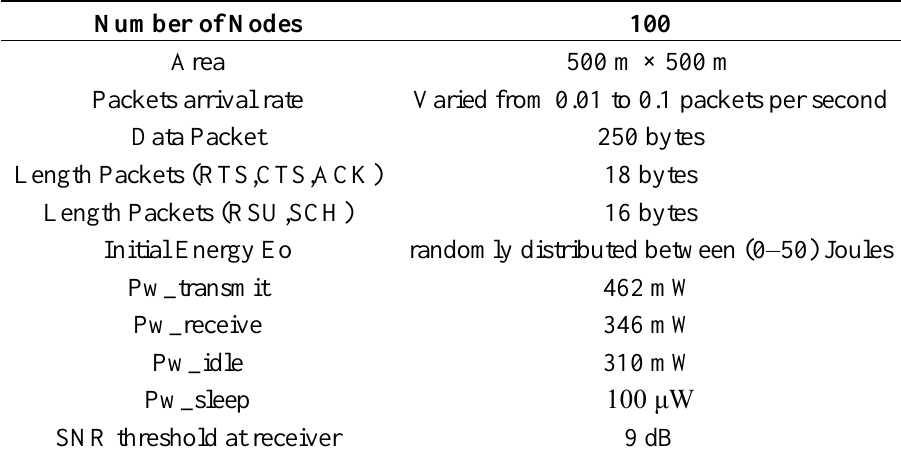
Table 2. Simulation